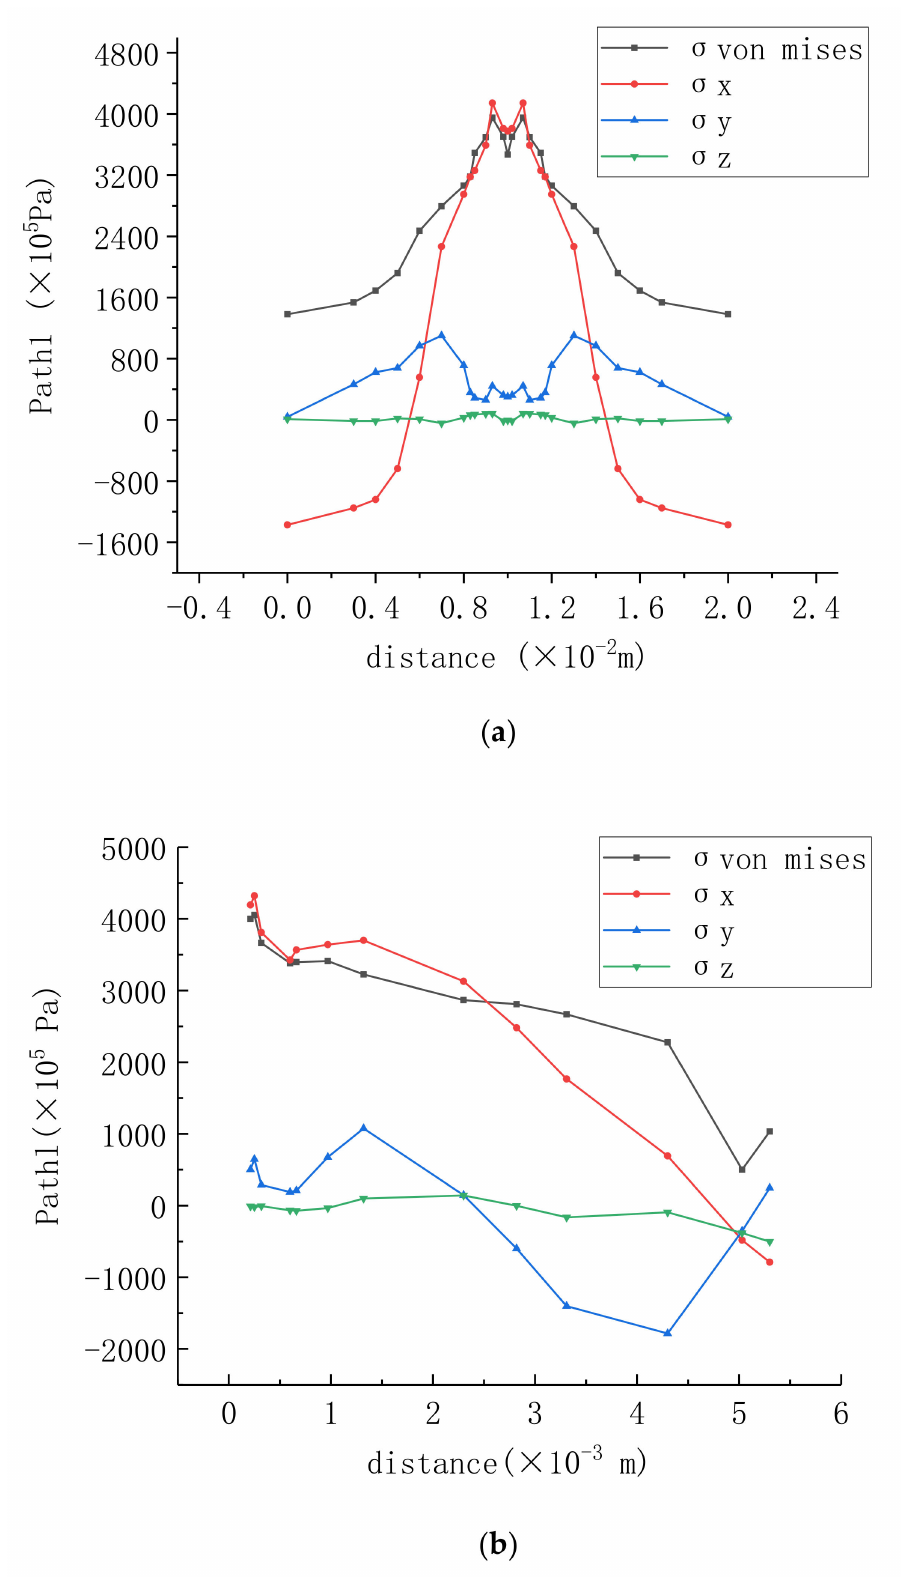
Figure 10. Residual stress distribution in two paths. ( a ) Residual stress distribution in path 1. ( b ) Residual stress distribution in path